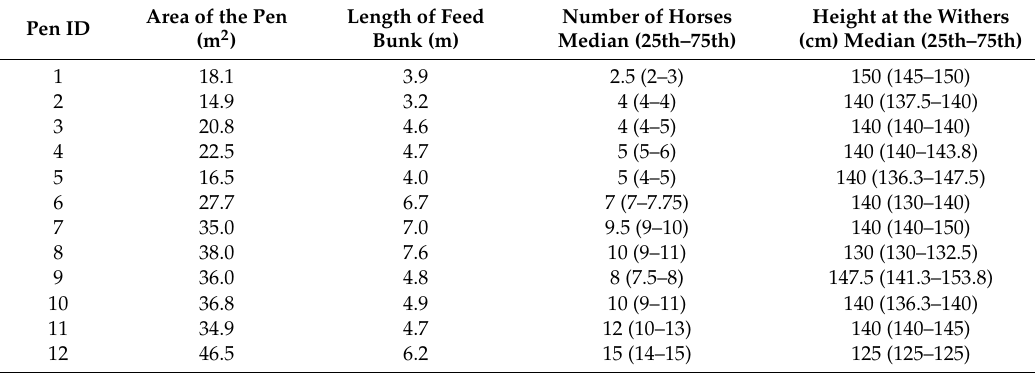
Table 1. Area (m 2 ) and feed bunk length (m) of the 12 multiple pens evaluated in the seven surveys conducted between April and June. The median values (plus 25th–75th percentiles) for the number and the height (at the withers) of the horses within each pen are